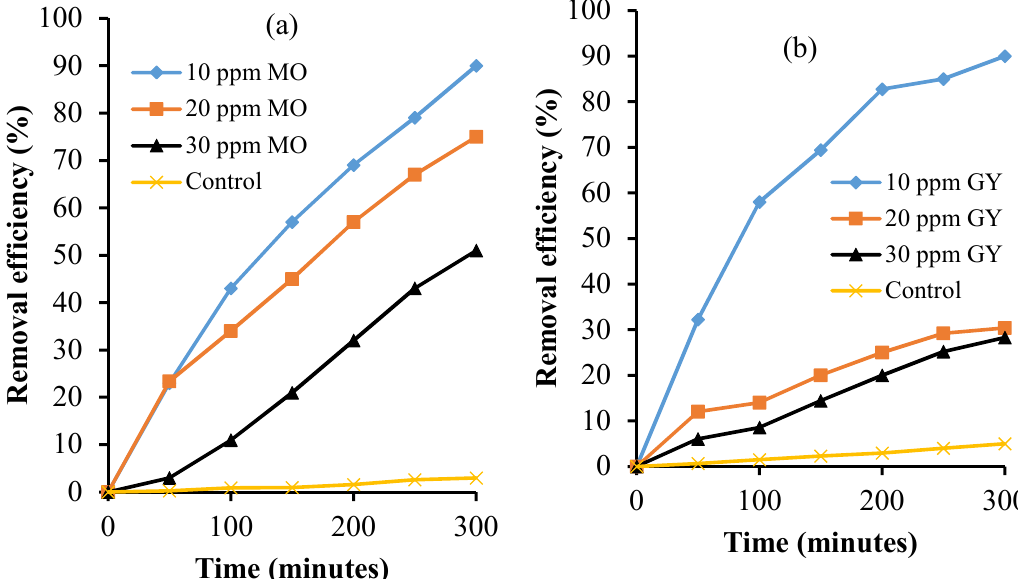
Figure 8. Photodegradation profiles of ( a ) MO and ( b ) GY at different initial concentrations obtained by using 2%C-TiO 2 -CFA / PAN membrane under sunlight irradiation (107,600 lux of light intensity), at ambient pH.